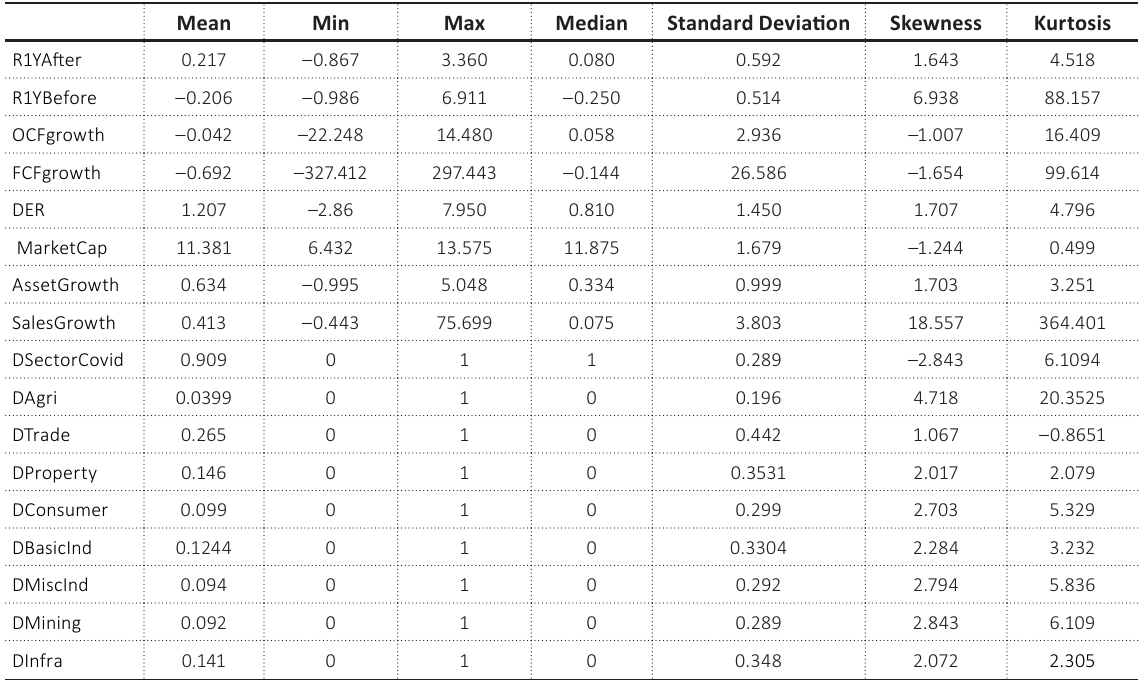
Table 3. Descriptive